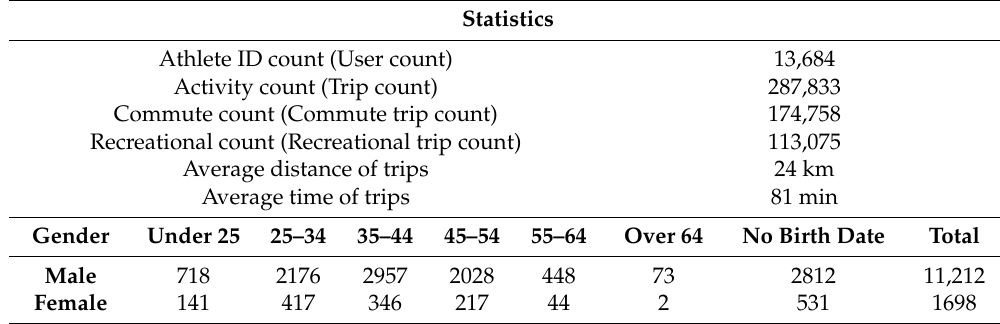
Table 2. Demographics of Strava cyclists in